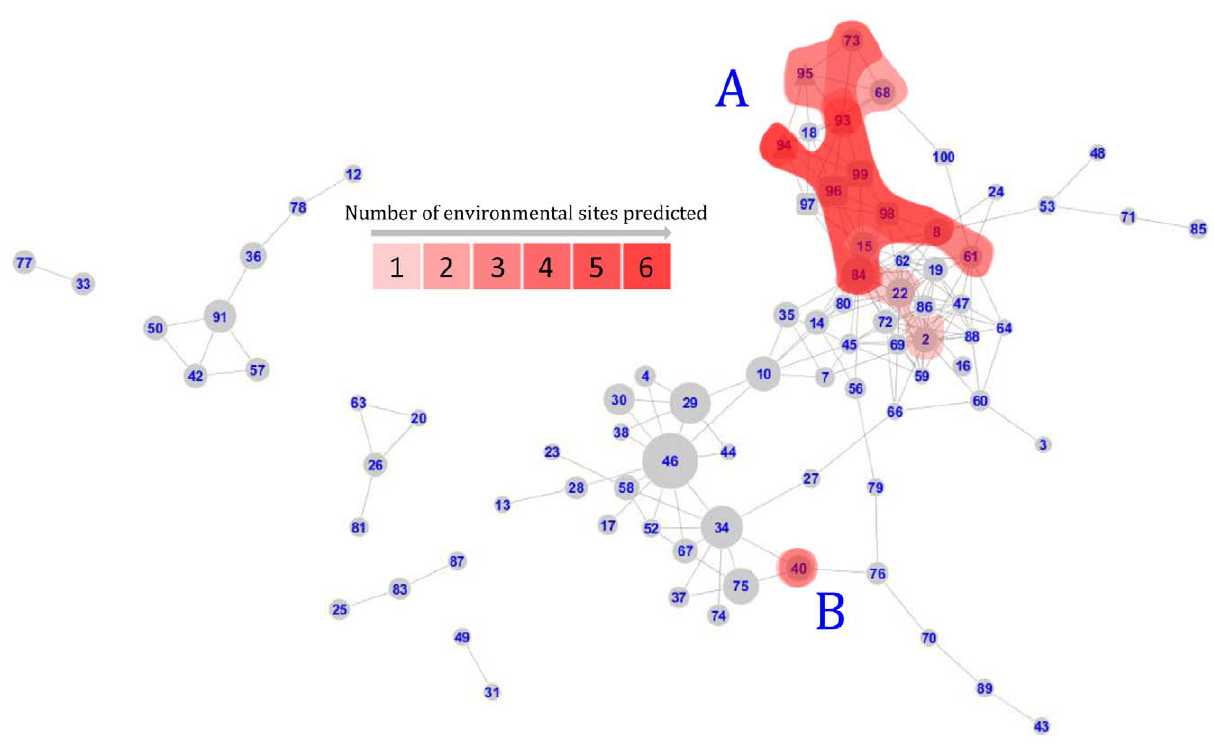
Figure 3. Modules predictive of environmental sampling sites. Modules in red predict membership of at least one environmental sampling site by GALGO with a sensitivity and specificity of . 70%. The number of sites that each module could predict is illustrated by shading. Modules are split into a major group (A) and a minor group (B).